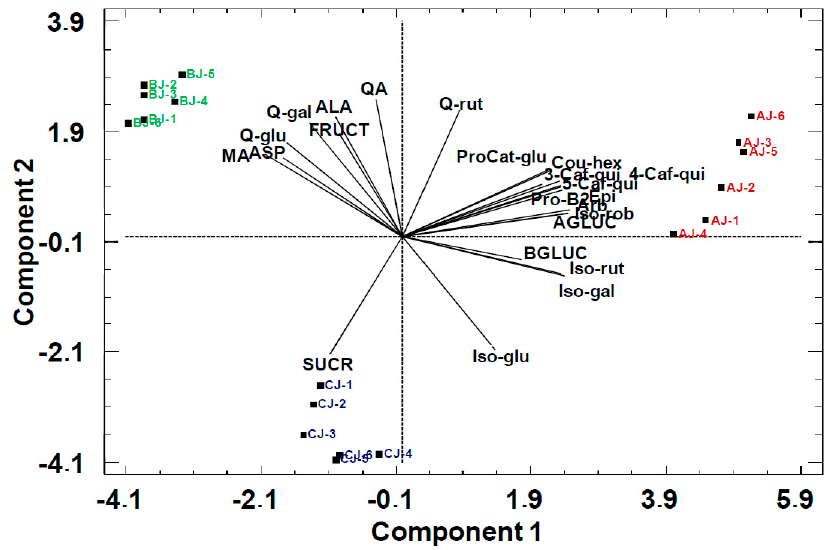
Figure 5. PCA bi-plot of peach purees with primary metabolites and phenolic compounds as statistical variables. FB: Freshly blended, C: Commercial, SL: Spring Lady cultivar, and M: Miraflores cultivar. Ending number is the batch number. PC1: 37%, PC2: 22%.